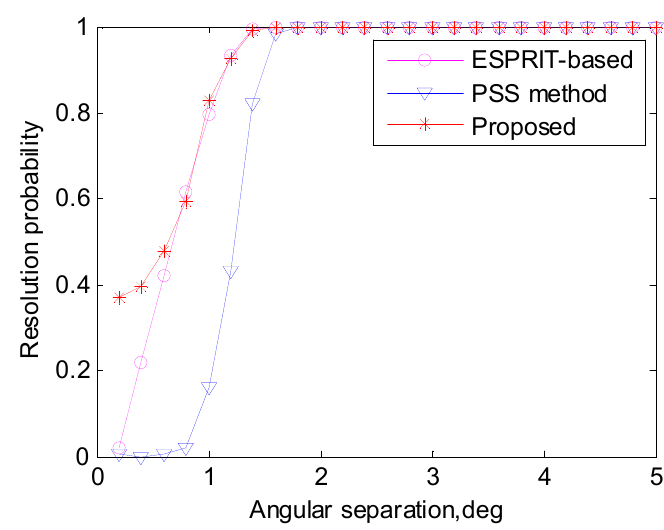
Figure 6. Resolution probability versus angular separation (SNR = 10 dB).